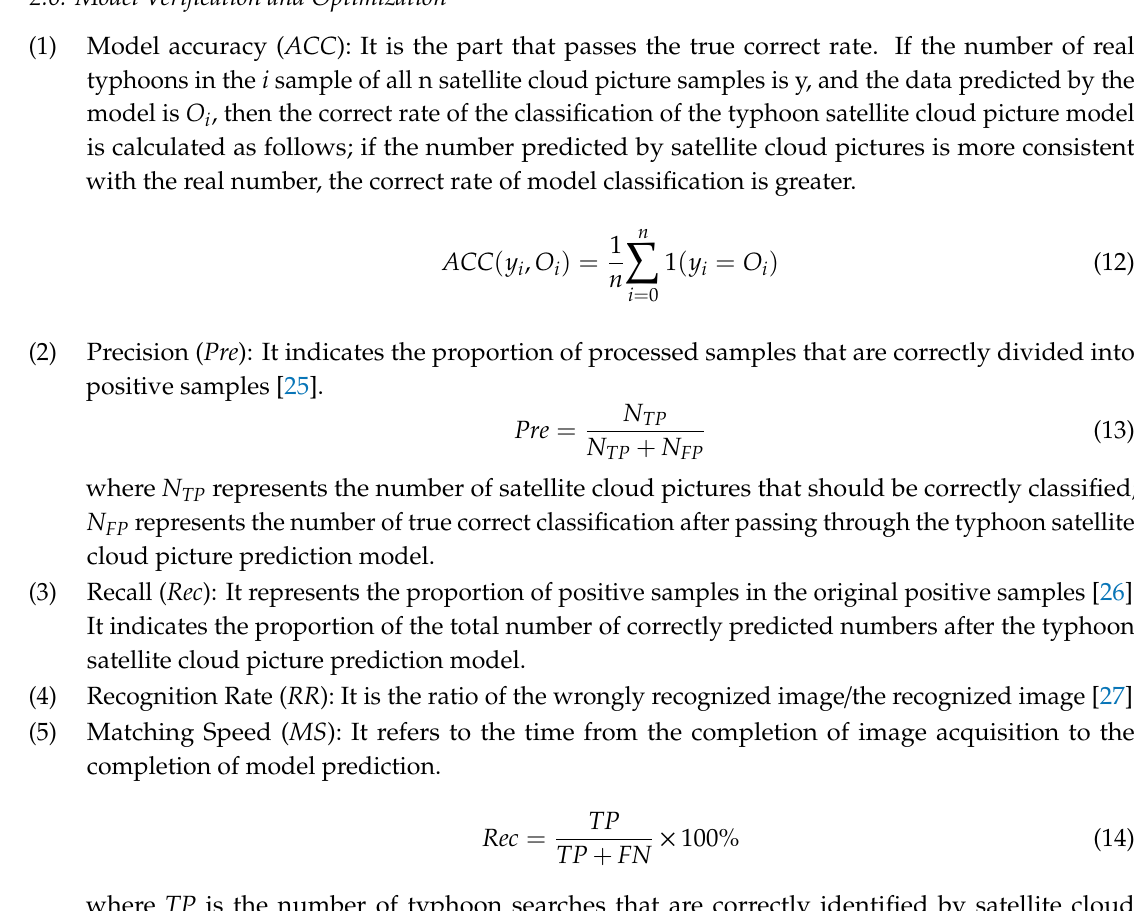
Figure 7. Overall framework of the GCN–LSTM fusion model.